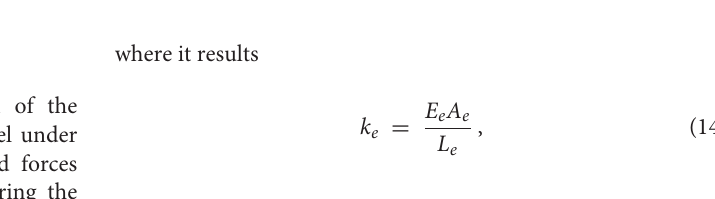
FIGURE 4 | Nodal displacements from the fully folded configuration exhibited by the non-actuated nodes of the TABS module, assuming L components of the nodal displacements along the x -axis are marked in blue, while the components along the y -axis are marked in red, and those along the z -axis are marked in